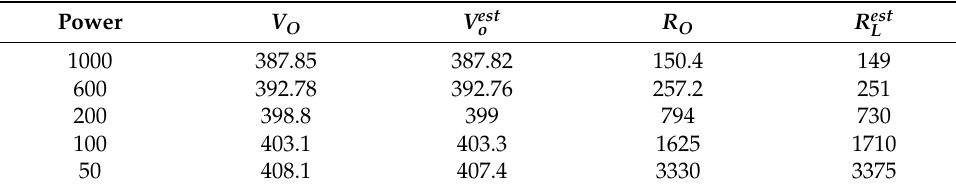
Figure 14. Experimental results, P O = 1000 W. Table 2. Simulation results